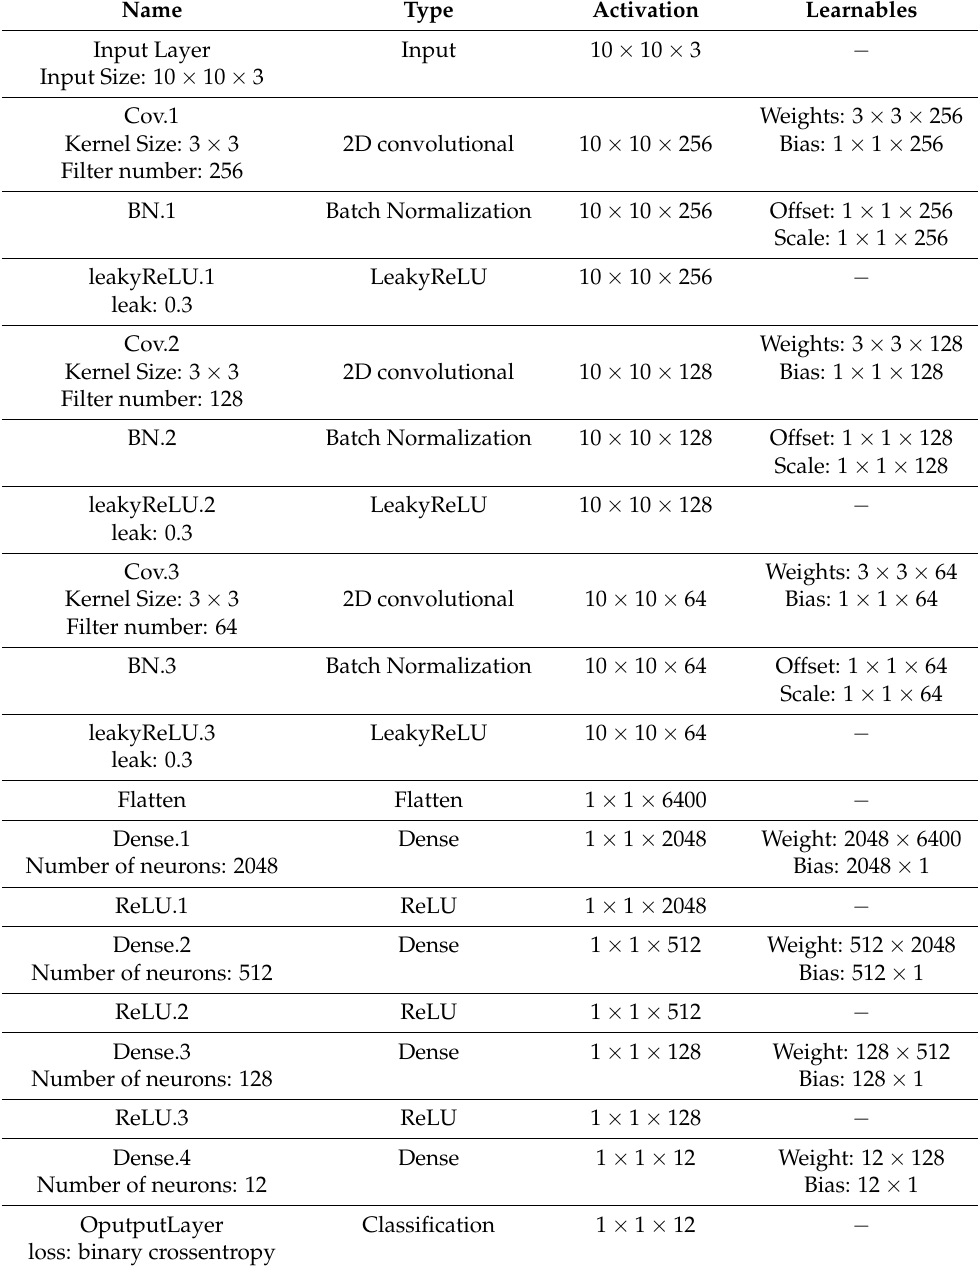
Table 1. Parameters of the first-stage rough DOA estimation